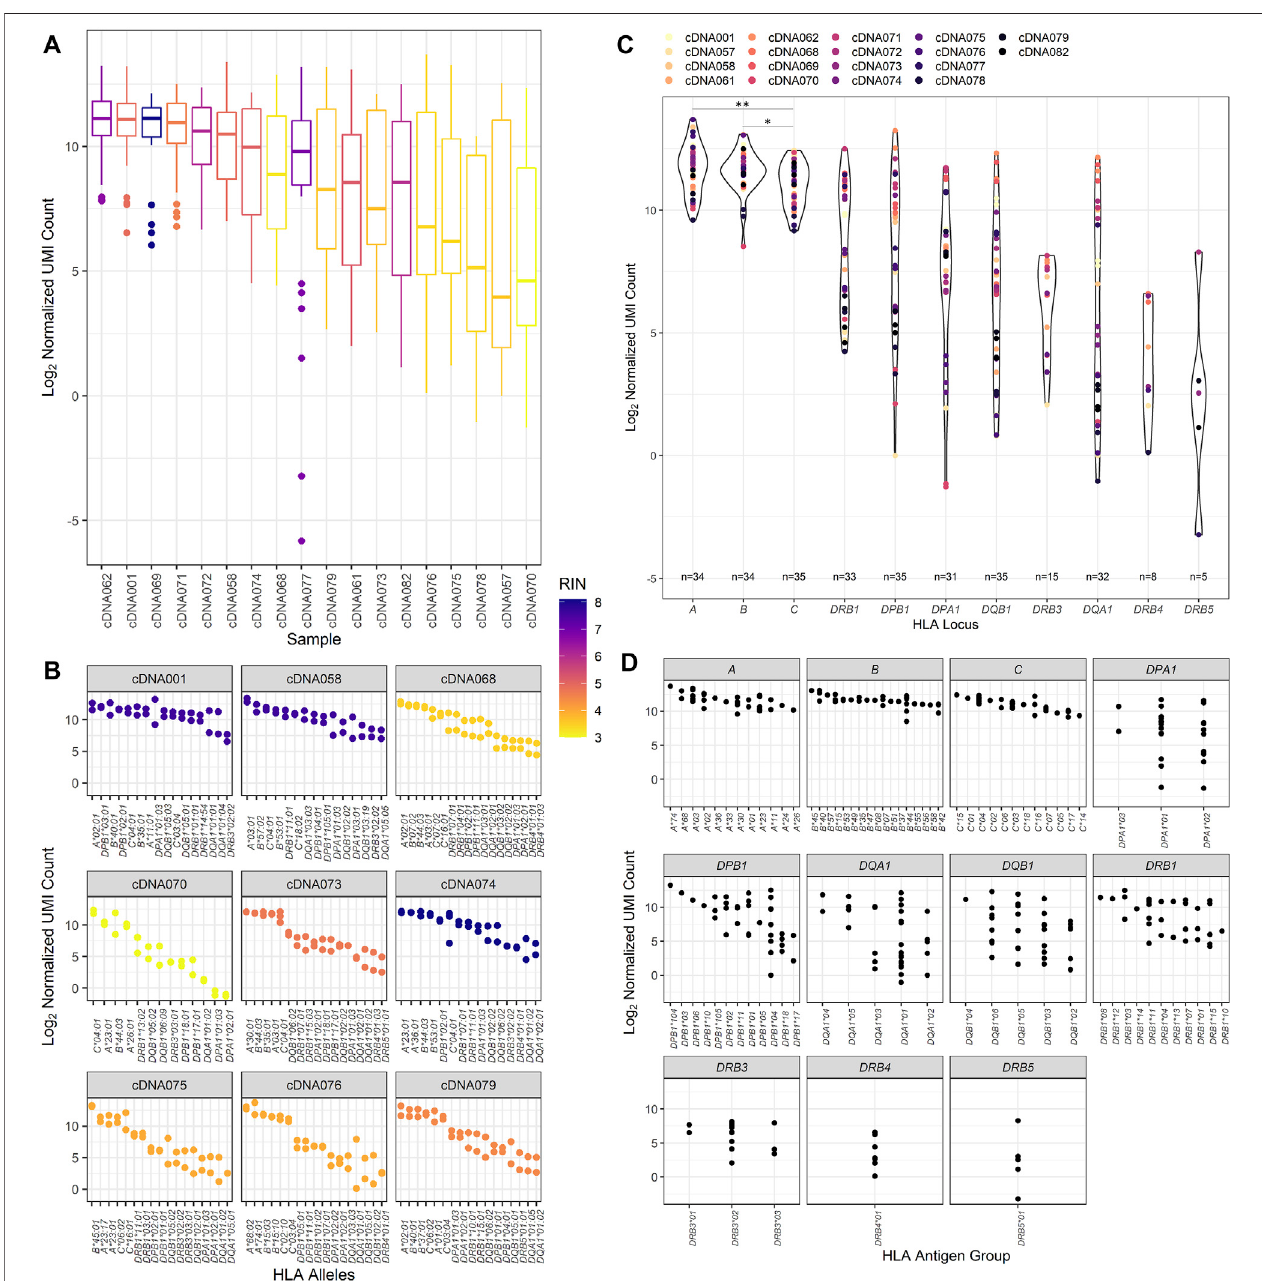
FIGURE 3 | RNA expression of the patient cohort as counted by unique molecular identi fi er. (A) The normalized UMI count distribution for each patient sample corresponding to the calculated RNA integrity number. (B) The distribution of the normalized UMI counts across several representative patient HLA alleles and their corresponding calculated RNA integrity numbers. All nine of these patient samples were used to evaluate interassay precision, and these data are re fl ected on the respective patient plots. (C) Normalized UMI counts at each of the classical HLA loci (* p value < 0.05, ** p value < 0.01). (D) The distribution of the UMI counts obtained for each HLA allele typed for the classical HLA loci for the study patient